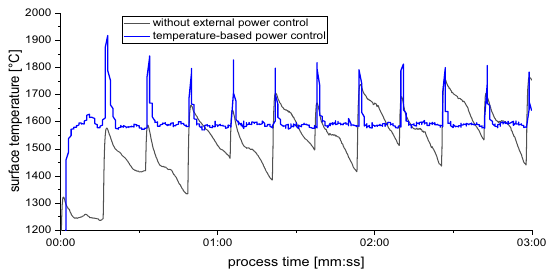
Fig. 1. Plasma jet induced surface temperature with and without PID control system. Temperature peaks occur due to end of scan line deceleration of the motion system.